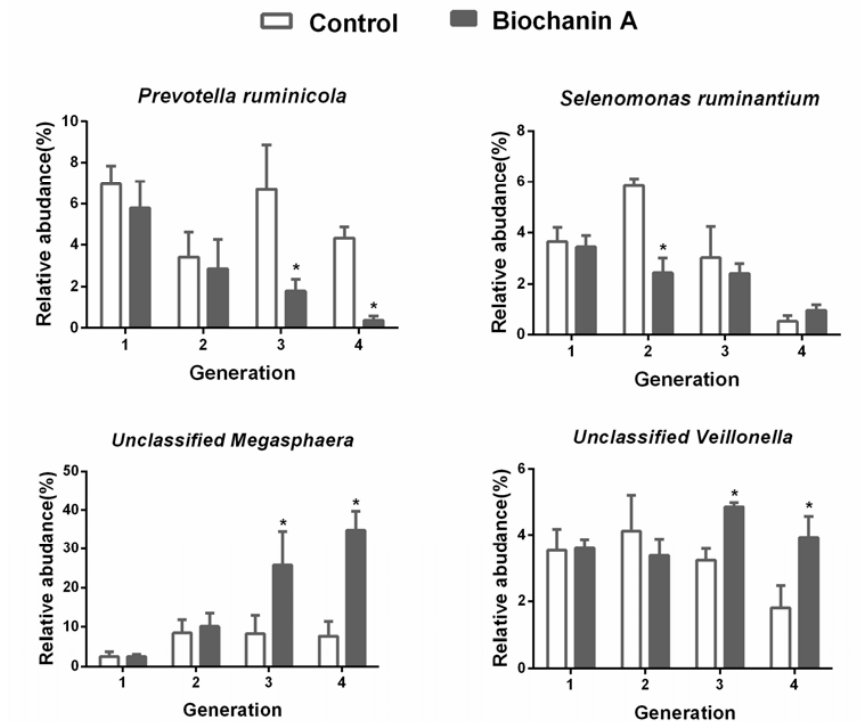
Figure 7. The effect of biochanin A on bacterial abundance in anaerobic media of different culture generations. Treatments included controls (only DMSO) and anaerobic medium with exogenous addition of biochanin A. Asterisks (*) indicate a significant difference between treatments ( p < 0.05). Error bars represent SEM.